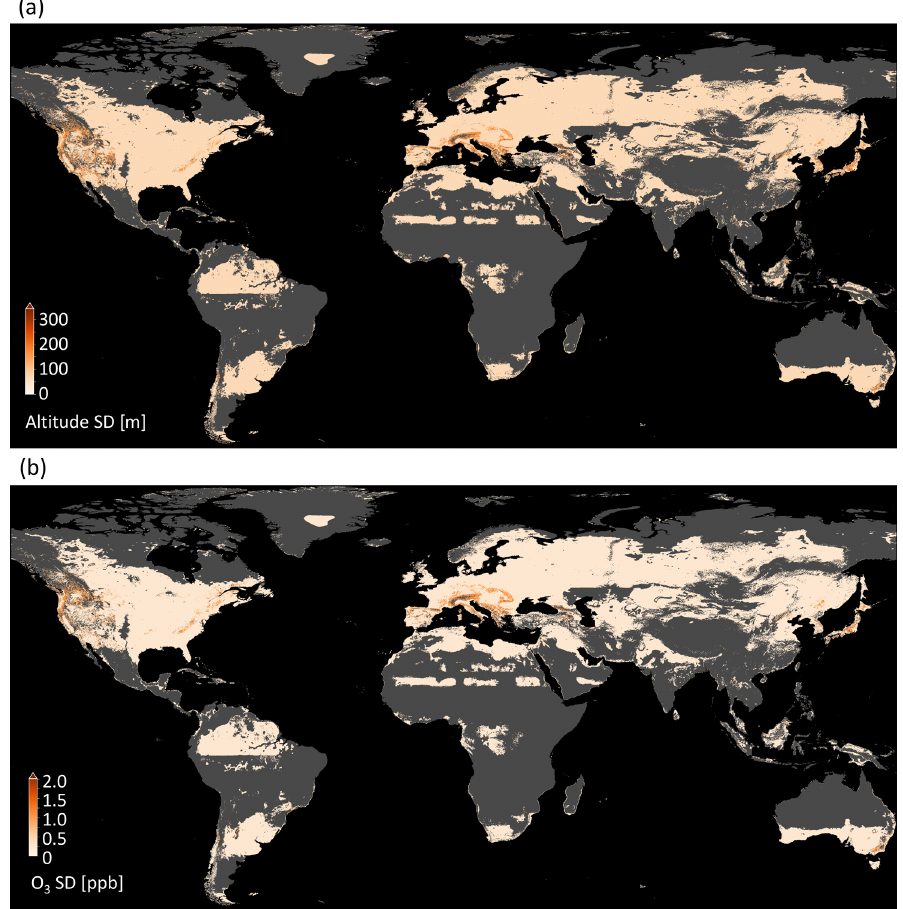
Figure 8. Results of propagating subgrid DEM variations through the model. (a) Spread of subgrid DEM data. (b) Spread of ozone